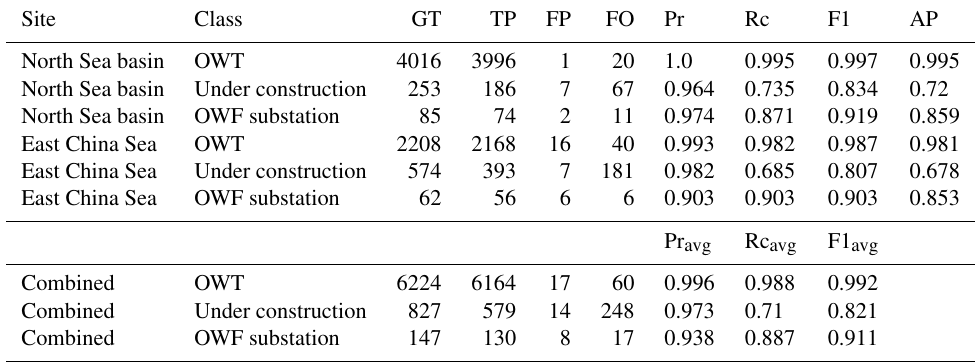
Figure 8. The temporal development of all 9941 objects and their corresponding class in the DeepOWT data set. The class and location in the interval 2021Q2 were derived using a CNN; in all other intervals, the class was derived by the swath profile analysis (see Fig. 6). Table 2. Overview of all calculated metrics for the CNN cascade detections on the 2021Q2 global Sentinel-1 median composite for each class separately. The detections were evaluated with the 2021Q2_nsb (North Sea basin) and 2021Q2_ecs (East China Sea) ground truth data